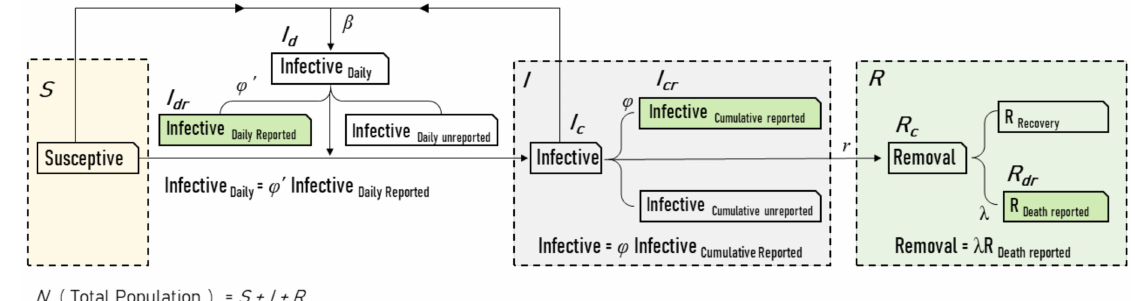
Figure 1. Susceptible–Infected–Recovered (SIR) model with unreported infection cases. The three big dashed boxes represent typical cabin parameters in the SIR model, wherein the infection data could be divided into two parts—reported and unreported. The solid green boxes represent the official released daily data on new infections, cumulative infections, and deaths, and might not represent the actual data on COVID-19 infection. Three new parameters were introduced to bridge such type of data suppression problem: ϕ ’ is the unreported infection rate (UIR) of newly reported infections, ϕ is the UIR of cumulative reported infections, and λ represents the recovery/mortality rate of reported deaths